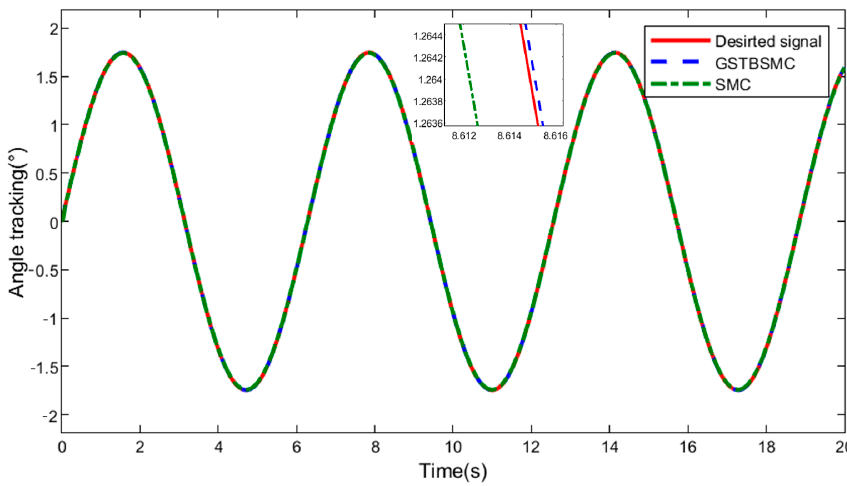
Figure 3. Comparison of the tracking results of GSTDO-GSTBSMC and NDO-SMC in Experiment 1.